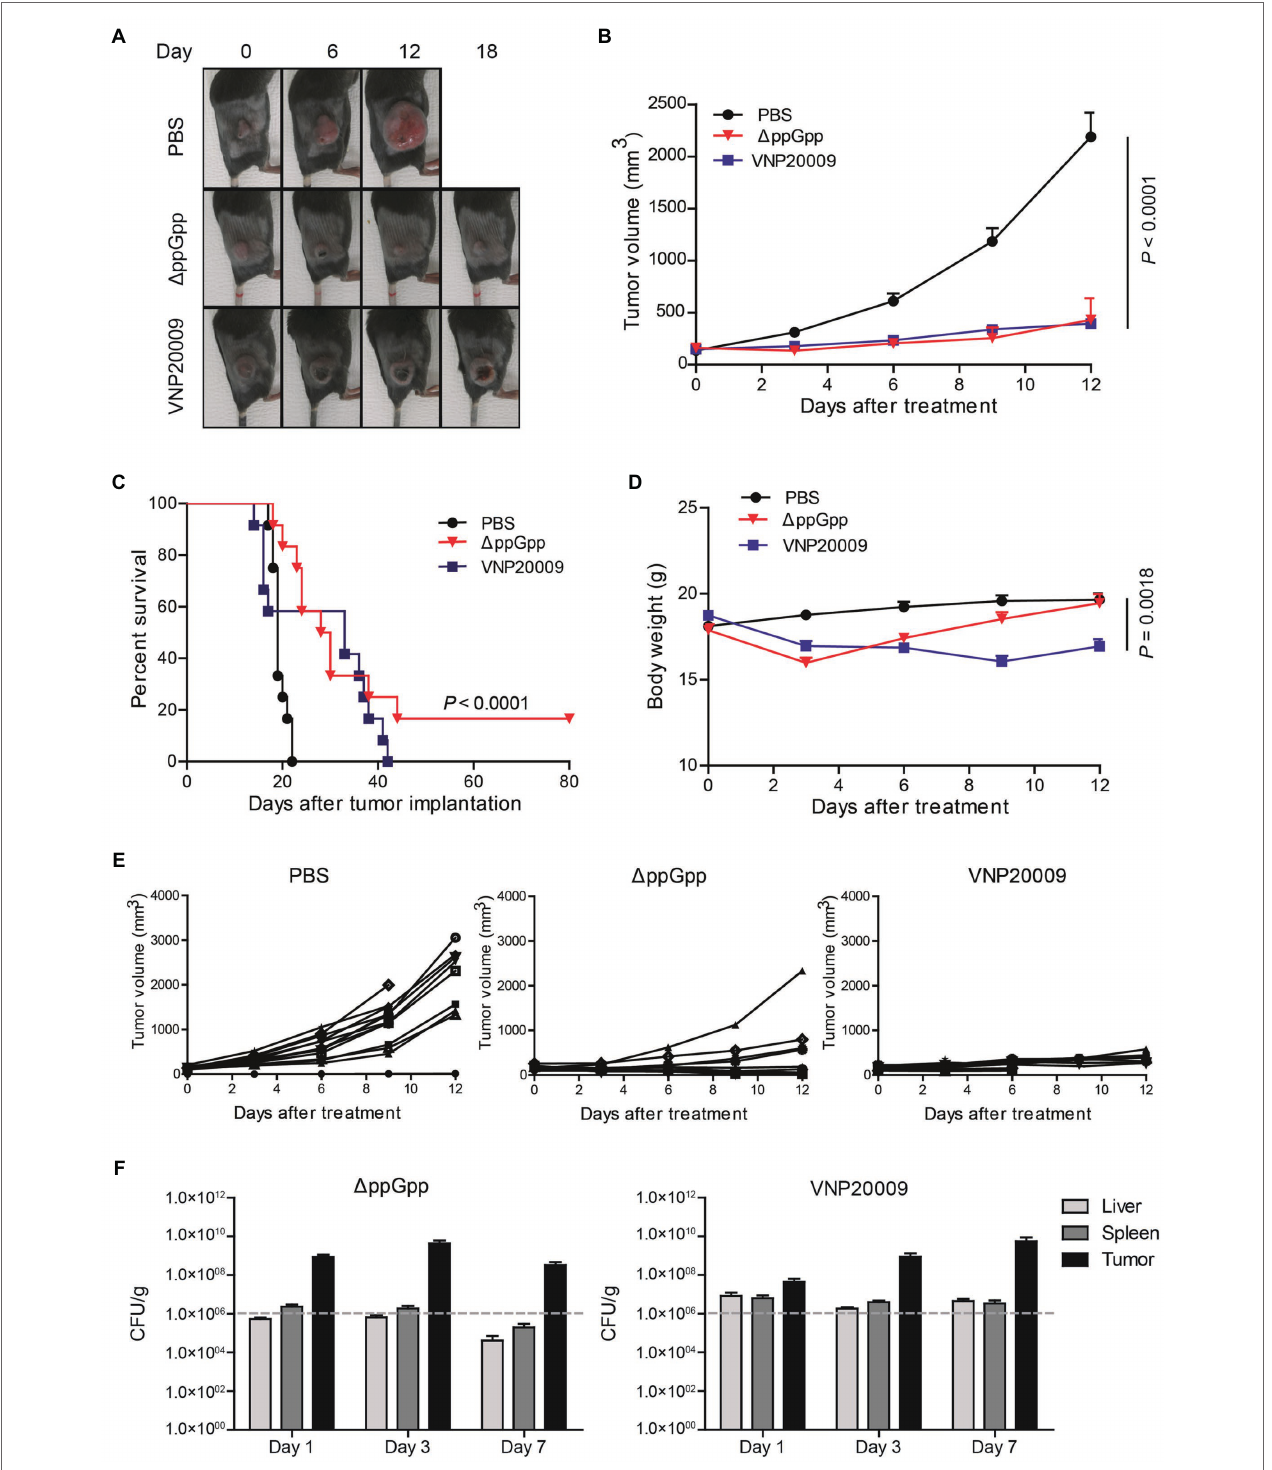
FIGURE 3 | Comparison of VNP20009 and Δ ppGpp in terms of animal survival and weight loss. (A) Photographs of subcutaneous tumors in representative mice. (B) Tumor growth curve in MC38-bearing mice, n = 12, p = 0.0001. (C) Animal survival curve of control, Δ ppGpp-, and VNP20009-injected groups, n = 12, p < 0.0001 between PBS and Δ ppGpp. (D) Change in body weight of mice after bacterial injection, n = 12, p = 0.0018 between PBS and VNP20009. (E) Tumor size change from individual mice. (F) Bacterial distribution in MC38-bearing mice at 1-, 3-, and 7-day post-bacterial injection, n =